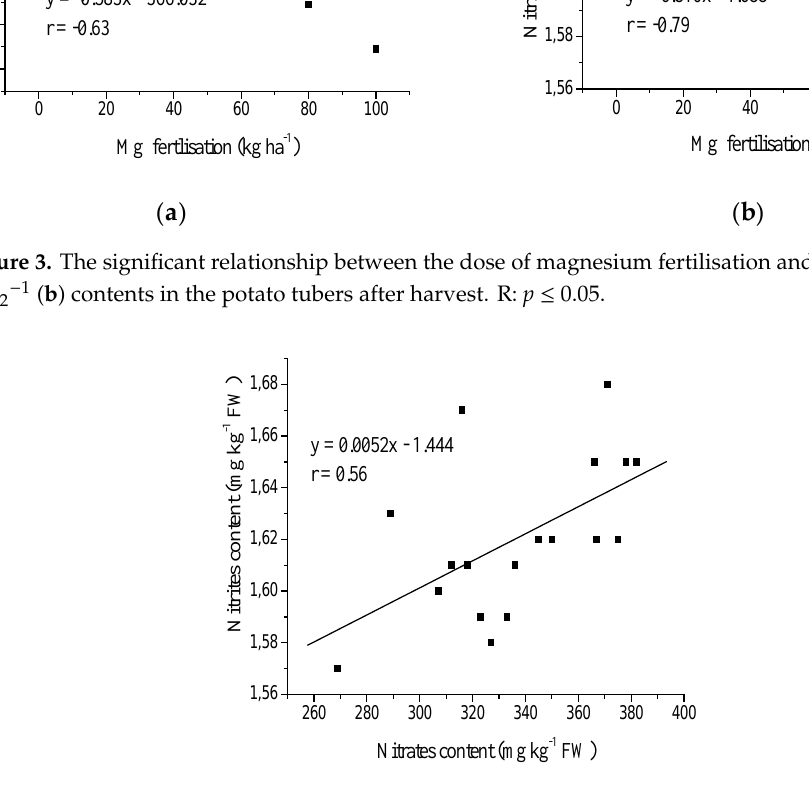
Figure 4. The significant relationship between nitrates and nitrites content in the potato tubers after harvest. R: p ≤ 0.05.